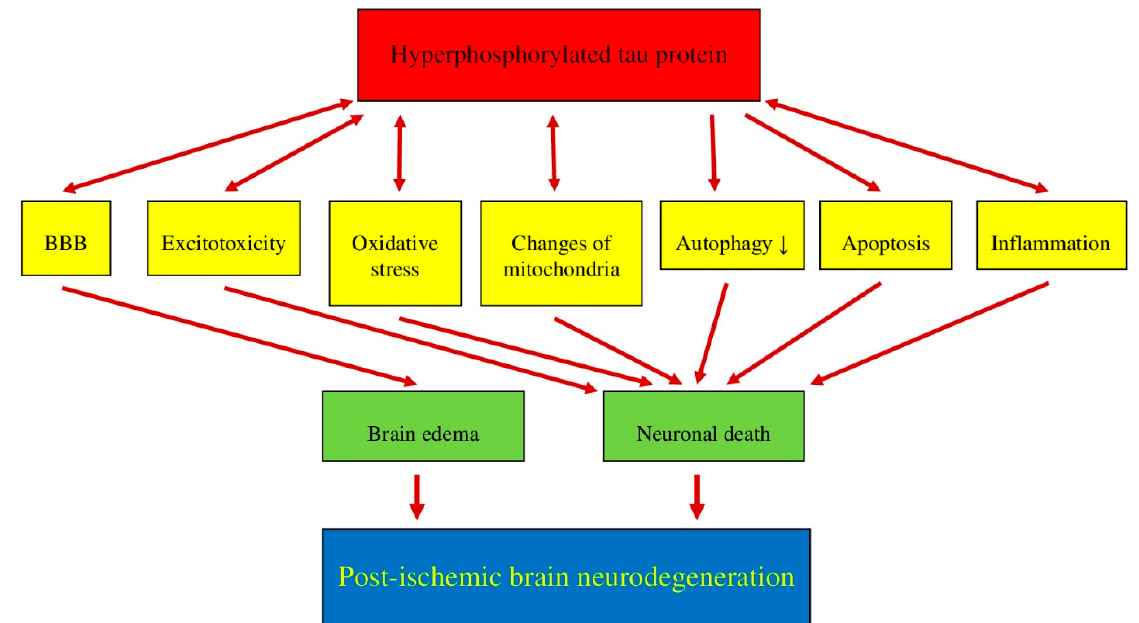
Figure 2. Interrelationships between hyperphosphorylated tau protein and post-ischemic brain neurodegeneration. ↓ —decrease. BBB—blood-brain barrier .